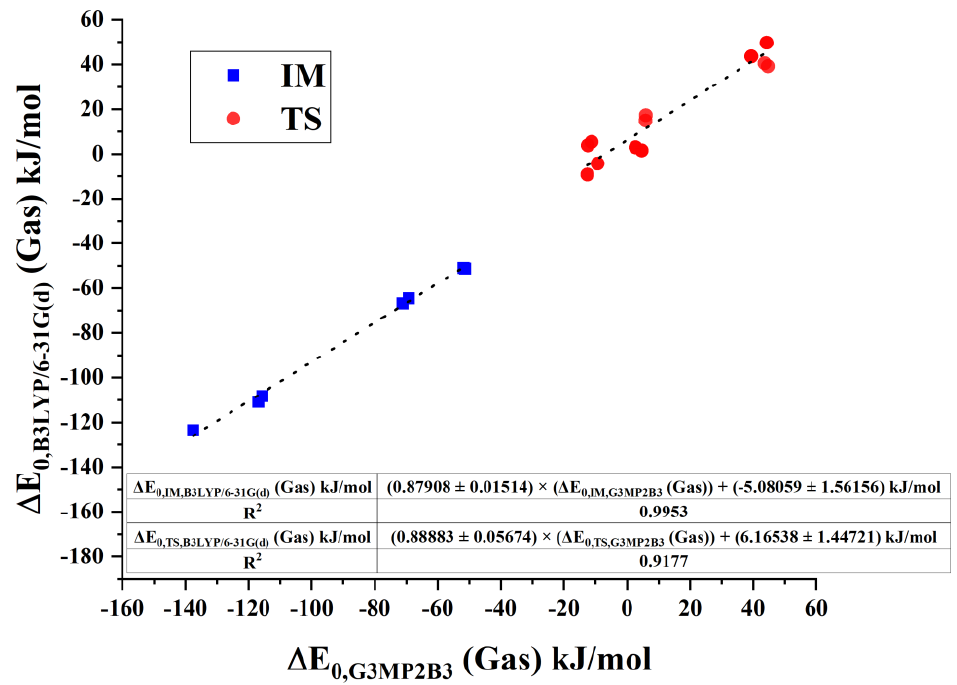
Figure 8. Comparison of intermediate and transition state energies in gas phase obtained by B3LYP/6-31G(d) level of theory and G3MP2B3. Fitted plots are marked in dotted lines.